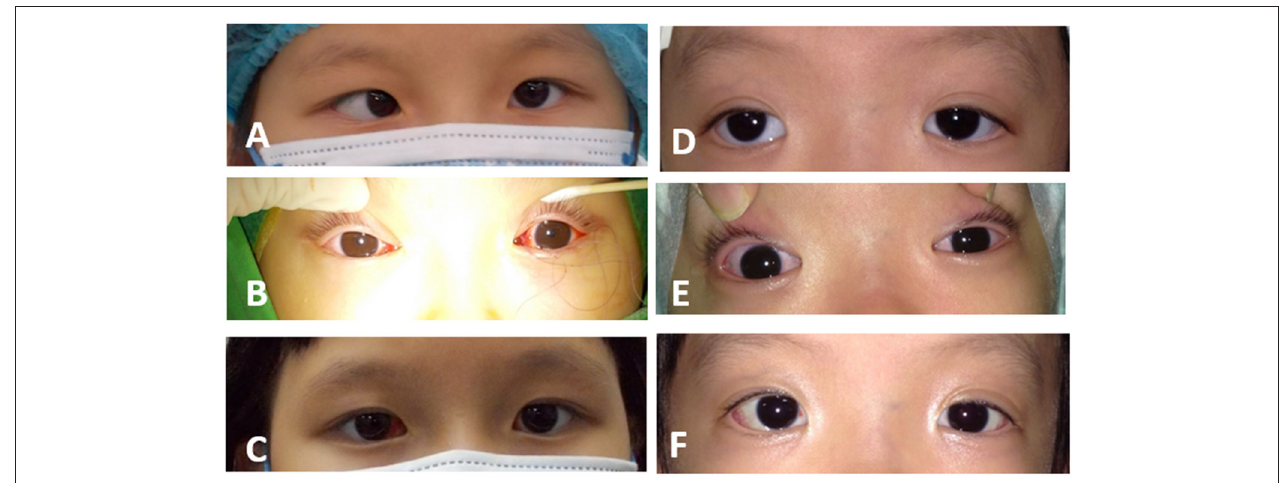
FIGURE 1 | Perioperative photographs of patients who underwent the novel method. (A) A 6-year-old girl showed 45 PD esotropia before the operation. (B) Adjustment was performed intraoperatively with assistance of the corneal light reflex. (C) At the 1-week postoperative visit, the girl showed orthophoric results. (D) A 5-year-old girl presented with 45 PD exotropia before the operation. (E) The end point of adjustment was shown during strabismus surgery. (F) The girl showed orthophoria at her 1-week postoperative visit.